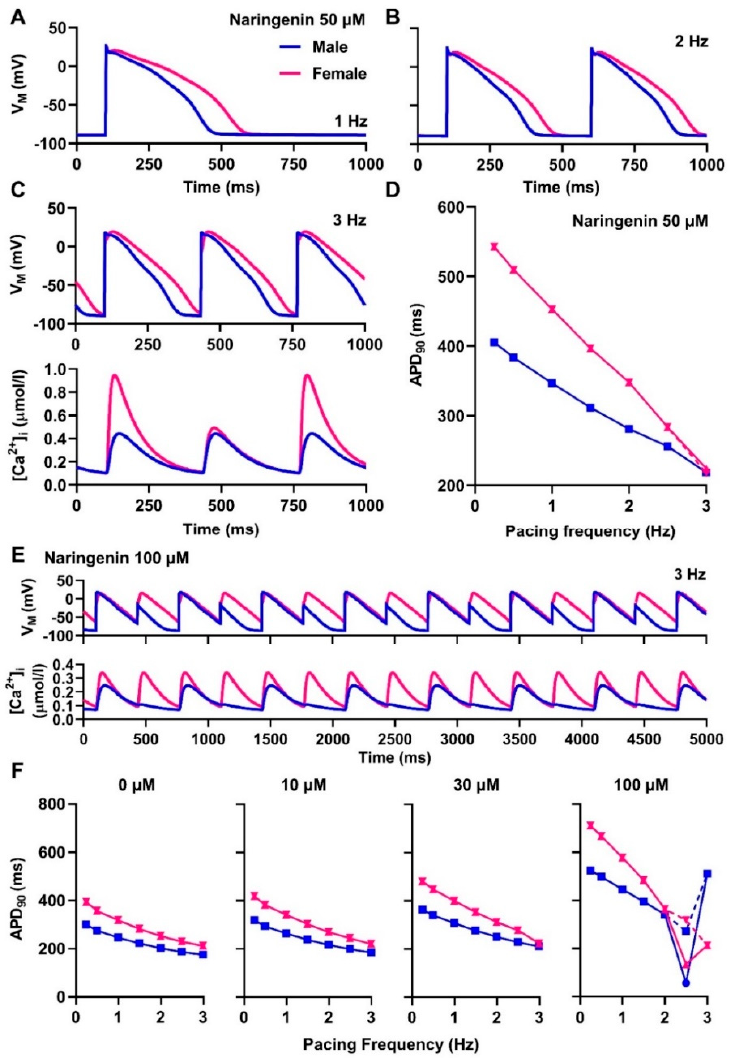
Figure 3. The rate-dependent effect of naringenin on human ventricular action potentials. ( A – C ) The rate-dependent effects of 50 µ M naringenin on male and female action potentials. At 3 Hz pacing frequency ( C ), both calcium and action potential (AP) alternans were documented in the female AP, but not in the male AP. ( D ) The frequency–APD curve displaying the relationship between pacing rate and changes in AP duration at 90% repolarization (APD 90 ) in response to the administration of 50 µ M naringenin. ( E ) The effect of 100 µ M naringenin at 3 Hz pacing frequency. ( F ) The frequency–APD curve displaying the relationship between pacing rate and changes in APD 90 in response to the administration of other concentrations of